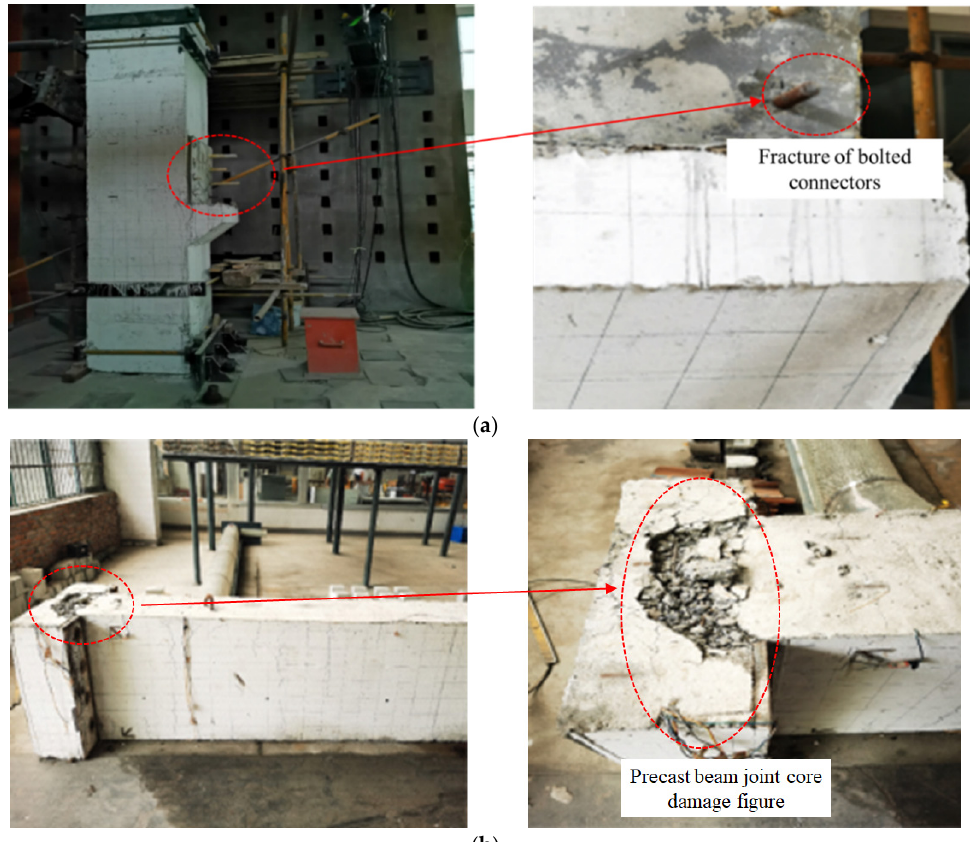
Figure 12. Joint damage image. ( a ) Precast column damage image after loading; ( b ) precast beam damage image after loading.